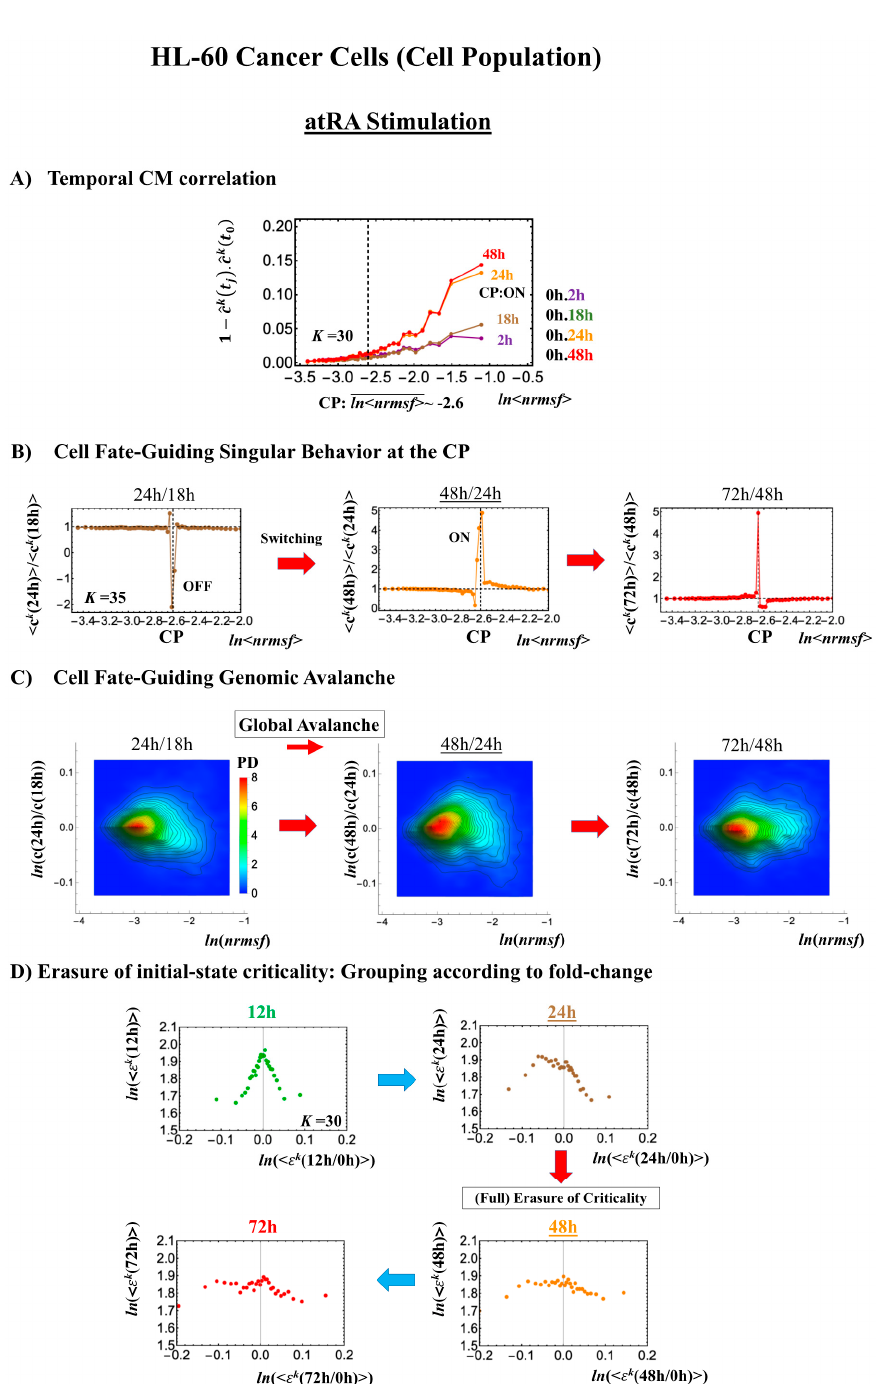
Figure 5. atRA-stimulated HL-60 cell population. ( A ) The divergent behavior of the temporal CM correlation with the initial whole-genome expression ( t = 0) occurs at 24 h ( K = 30: n = 420 mRNAs). ThisdivergentresponseoccursfortheONstateat24hindicatedby( B , C ).( B )Transitionofthehigher-order structure at the CP ( K = 35: n = 360 mRNAs) is suggested to occur at 24–48 h, when initial-state criticality is erased ( D ). The switching of singular behaviors at the CP occurs with bimodal behaviors of the fold-change around the CP. The dominant negative fold-change indicates that the OFF state (compact globule DNA) occurs at 18–24 h, while the dominant positive fold change (swollen coil DNA) occurs at 24–48 h. ( C ) The temporal change in the PDF shows that a global avalanche occurs from 18–24 h (PDF: contracted) to 24–48 h (swollen) to 48–74 h (contracted), which supports the switching behaviors of the CP ( B ). ( D ) The full erasure of initial-state criticality occurs at 24–48 h, which indicates a cell-fate change. Underlined numbers represent the timing of the cell-fate